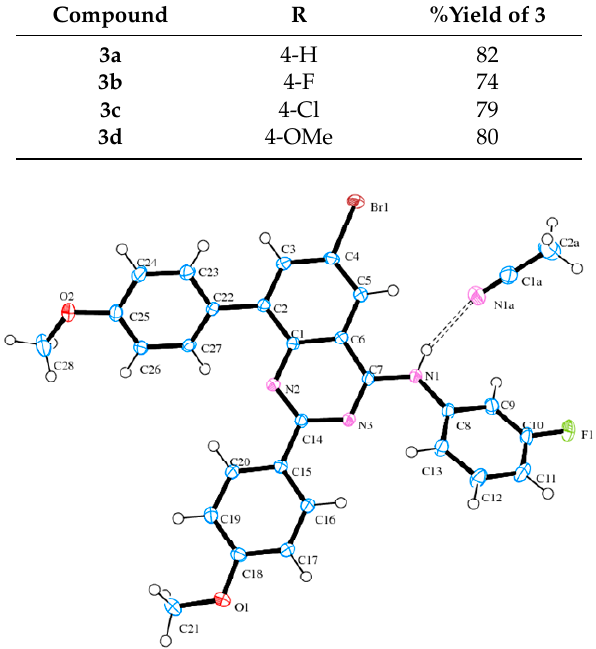
Table 2. Percentage yield of compounds 3a – d .